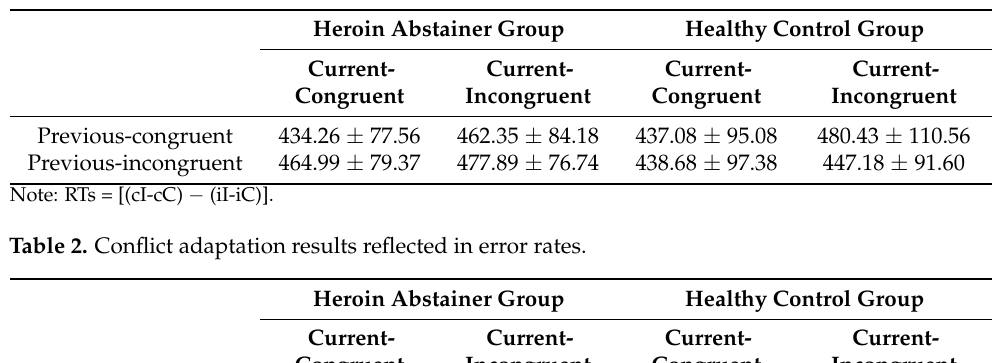
Table 1. Conflict adaptation results reflected in RTs.